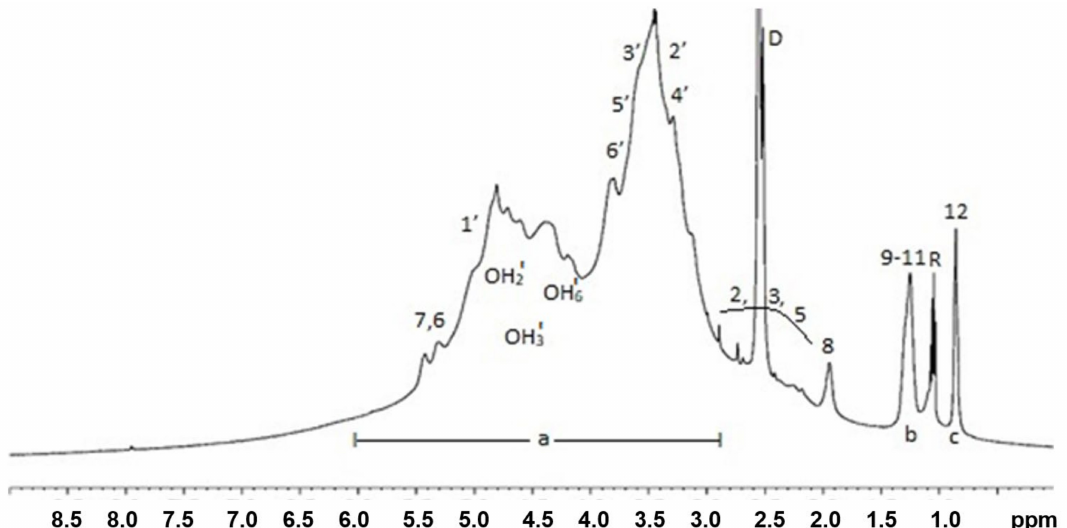
Figure 1. 1 H NMR spectrum of a CG–OSA adduct in d 6 -DMSO. The proton numbers follow the scheme shown in Scheme 1; D = dimethylsulfoxide (DMSO); R = methyl from